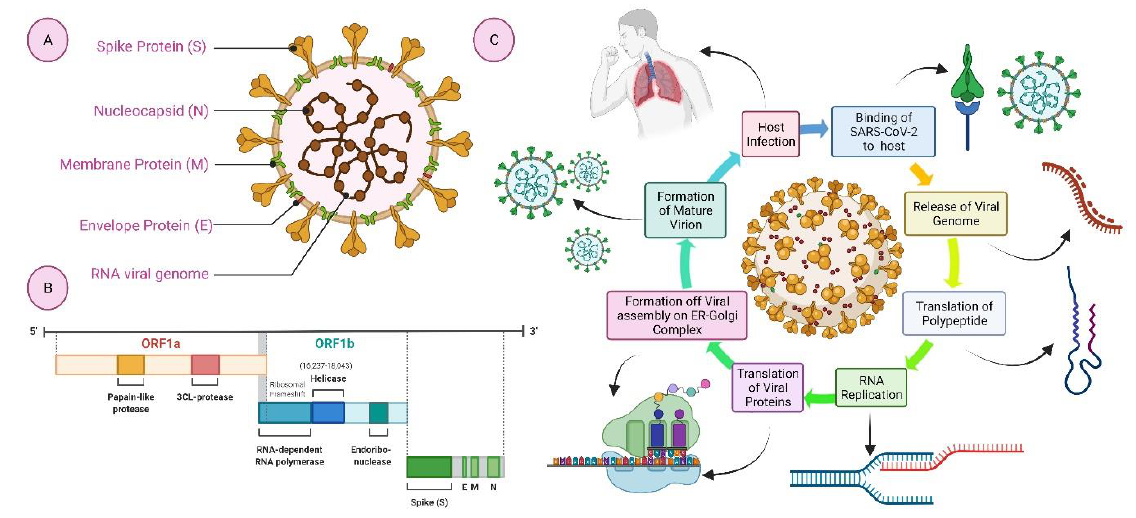
Figure 1. SARS-CoV-2 structural elements, genetic makeup and viral life cycle overview. ( A ) Structural organization of novel coronavirus; ( B ) Genomicmap of the novel coronavirus; ( C ) Lifecycle of novel coronavirus.